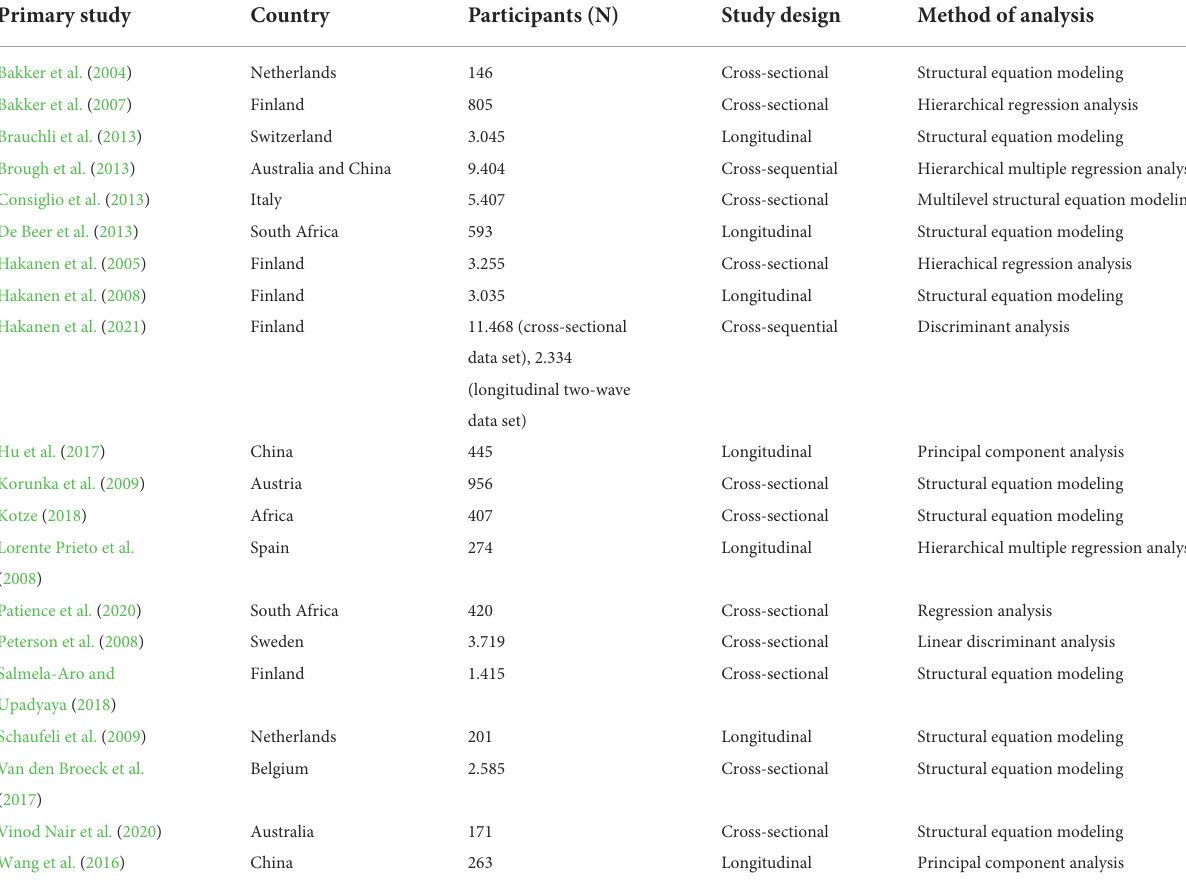
TABLE 1 Overview of the identified studies of the JD-R